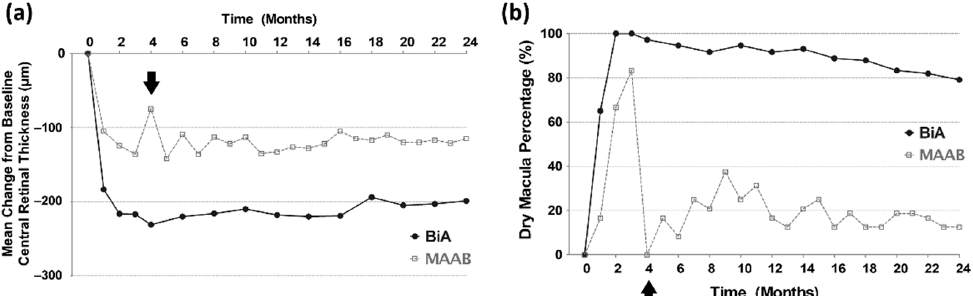
Figure 3. Anatomical outcomes from baseline to the 24th month. ( a ) MAAB group shows rapid worsening at the fourth month. ( b ) The BiA group maintains a higher percentage of dry macula than does the MAAB group over the entire period. Arrows indicate rapid anatomical worsening at the fourth month in the MAAB group.